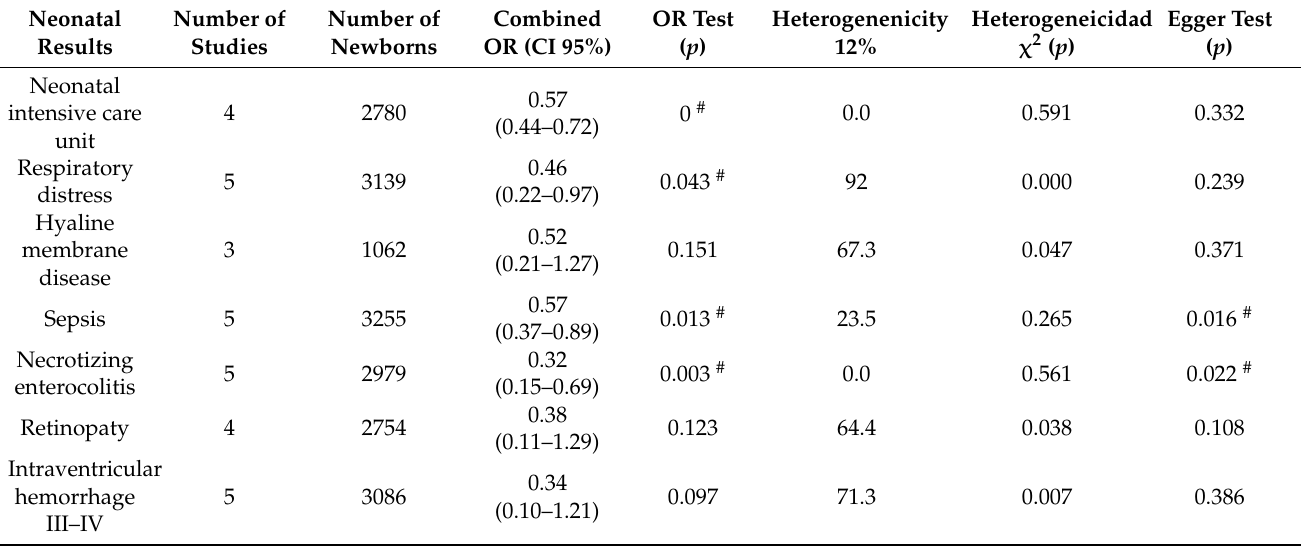
Table 8. Neonatal results of the triplet pregnancies included in the meta-analysis according to chorionicity.